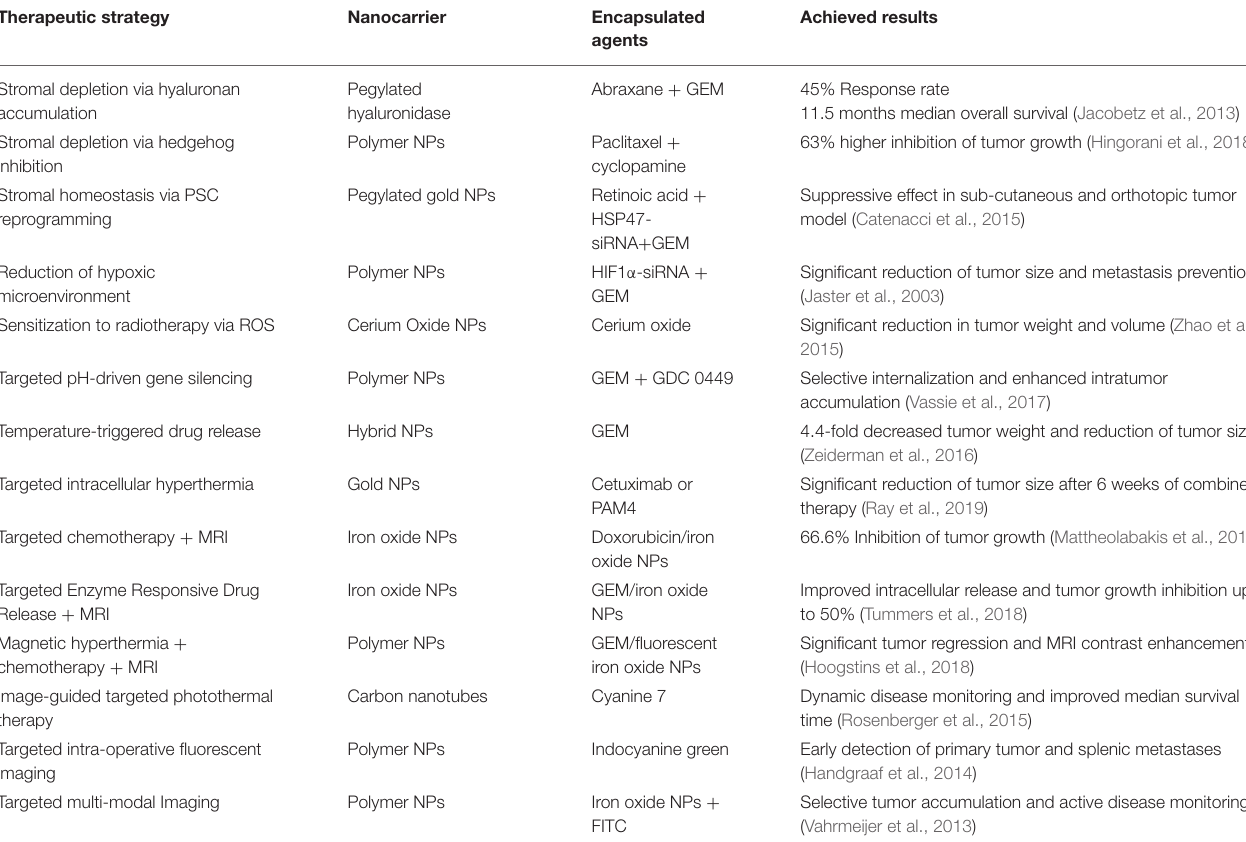
TABLE 1 | Nanomedicines for imaging and/or treatment of PDAC. Therapeutic